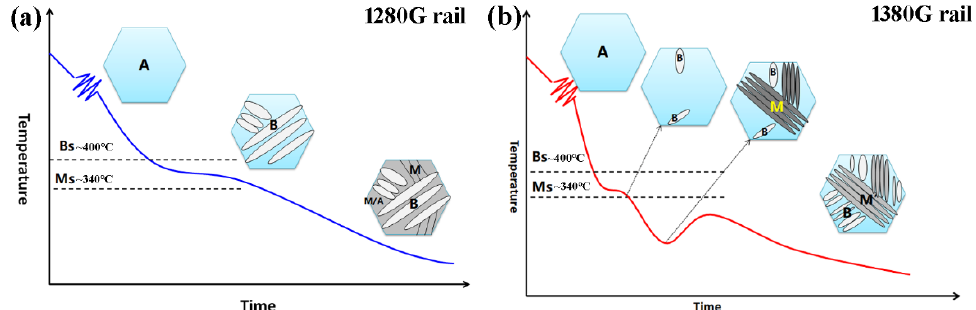
Figure 1. Schematic of the microstructural evolution of bainitic rail steels during natural air-cooling process and on-line heat treatment based on BQ&P concept. ( a ) Air-cooling process for 1280G rail steel; ( b ) on-line BQ&P for 1380G rail steel; A: austenite, B: bainite, M: martensite.